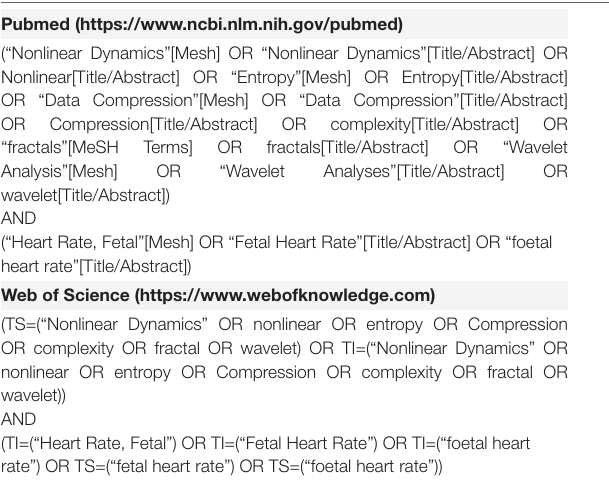
TABLE 1 | Online queries in Pubmed and Web of